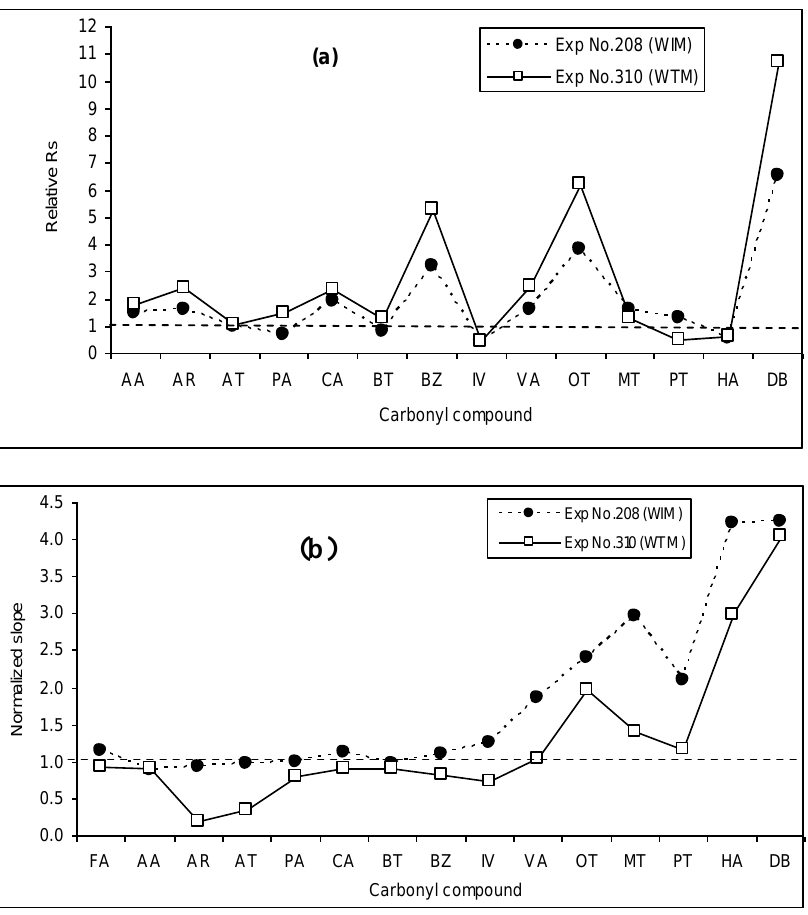
FIGURE 4. Normalization of experimentally determined resolution values (R and slope values: WIM and WTM phases, relative to ACN:water (70:30)